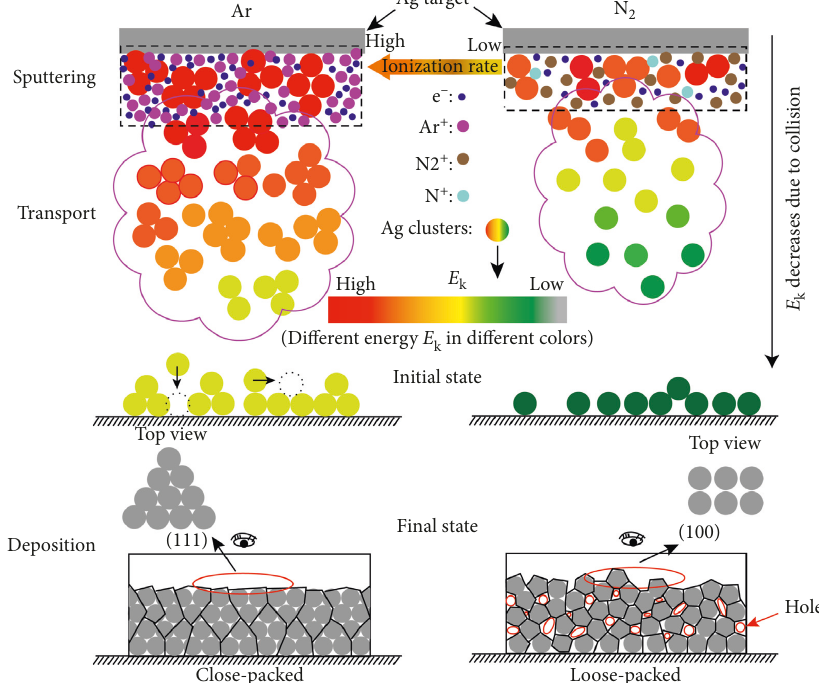
Figure 7: The sputtering deposition schematic diagram of silver thin films in pure Ar and pure N